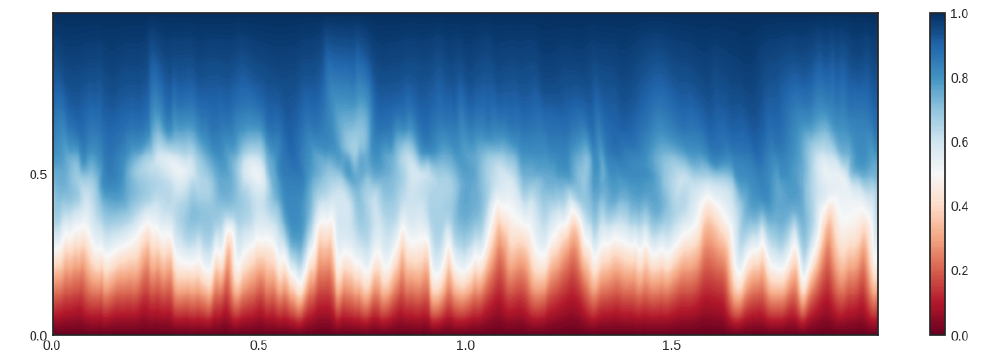
Figure 2. Two-dimensional (2D) snapshot of the streamwise velocity field along the Z-center plane.